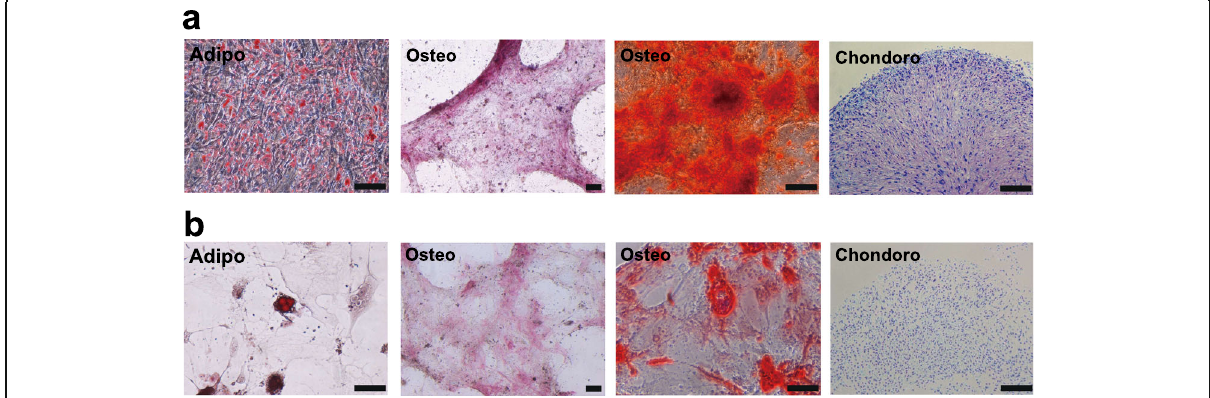
Fig. 2 a Adipogenic (Adipo), osteogenic (Osteo), and chondorogenic (Chondro) differentiation of LNGFR Low+ THY-1 High+ cells. Scale bars = 100 μ m. b Adipogenic (Adipo), osteogenic (Osteo), and chondorogenic (Chondro) differentiation of LNGFR + THY-1 + cells. Scale bars = 100 μ